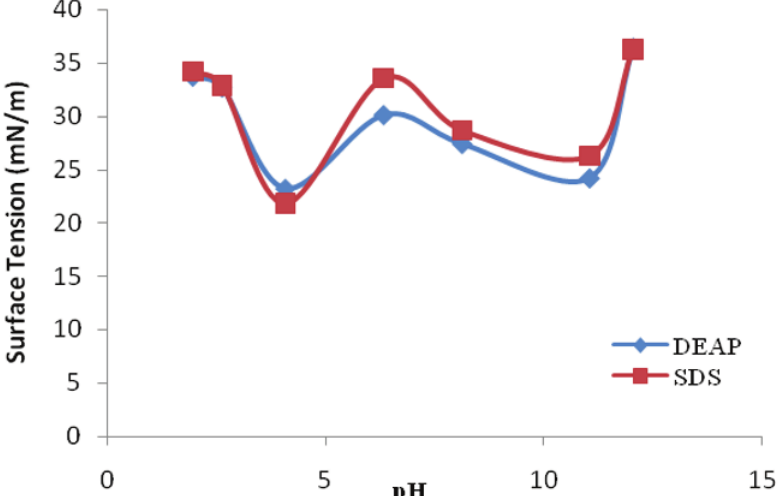
Figure 10. Effect of pH on surface tension of sodium phosphate-hydroxy ethanolamide and SDS at 0.25 g L -1 . DEAP = Sodium phosphate- hydroxy